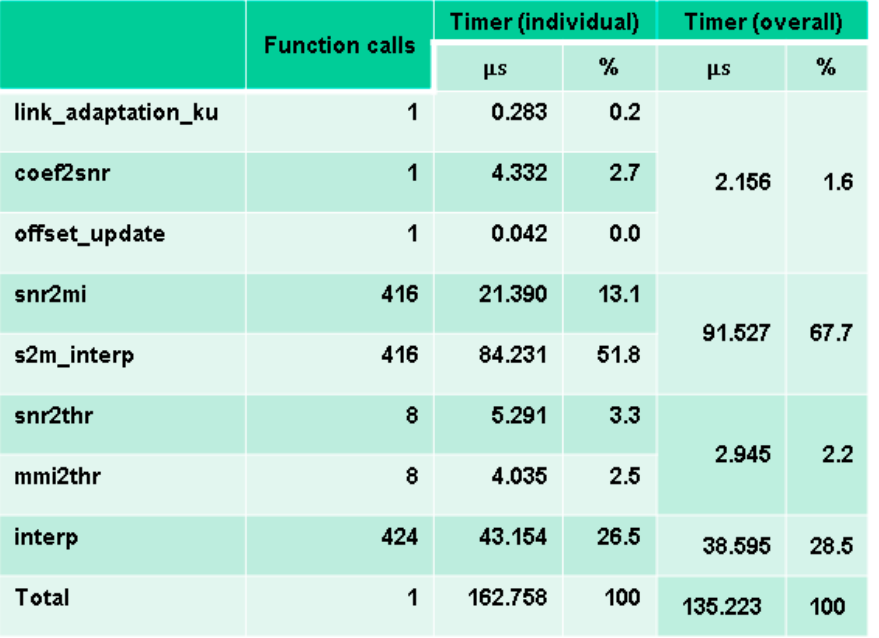
Figure 13. Linear interpolation.